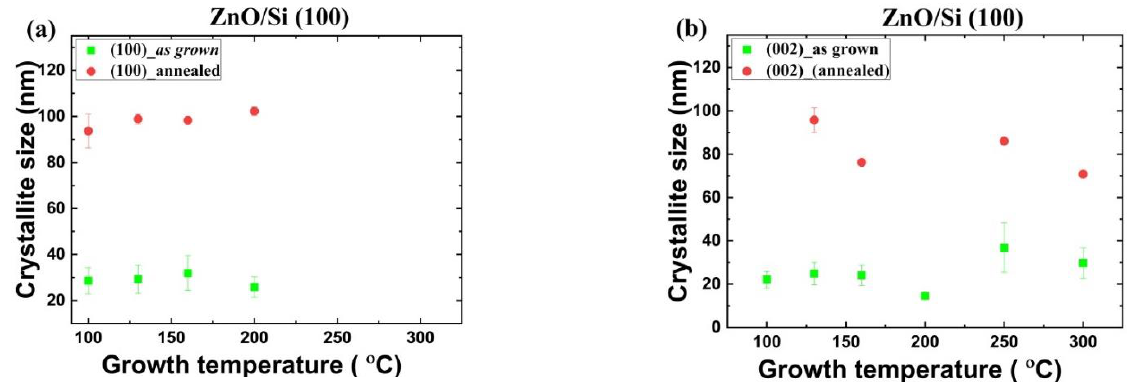
Figure 4. The size of crystallites oriented along ( a ) the [100] and ( b ) [001] direction for ZnO/Si(100) films.